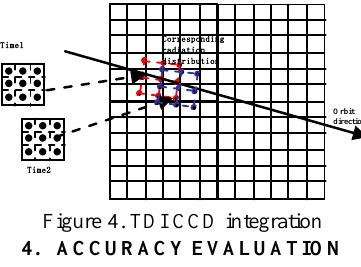
Figure 4. TDI CCD integration